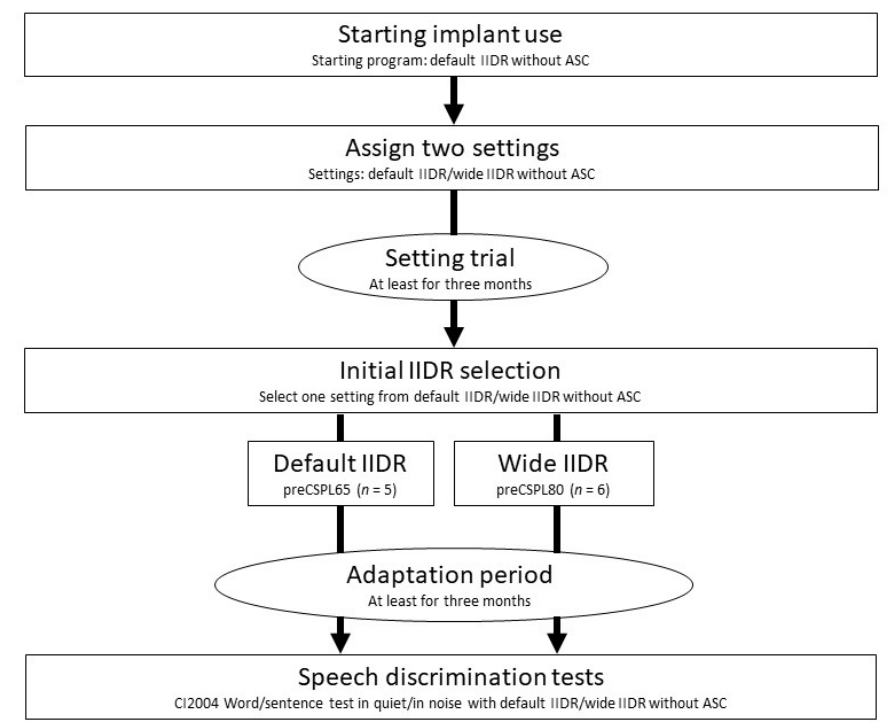
Figure 1. Summary of study procedures. The research protocol was initiated at the time of “assign two